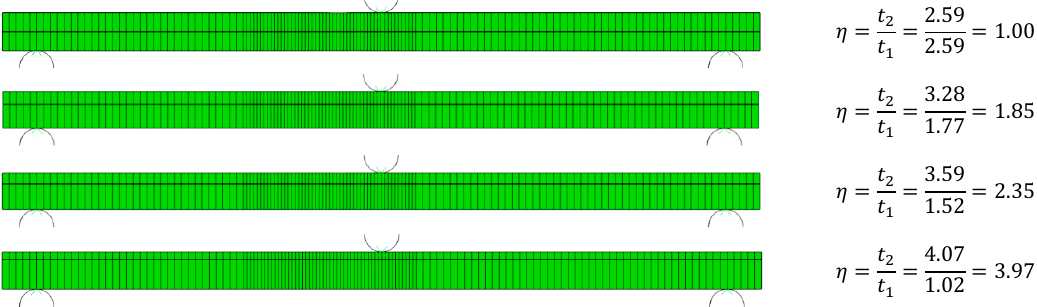
Figure 6. Four cases of numerically simulated laminates for comparison with analytical solution.